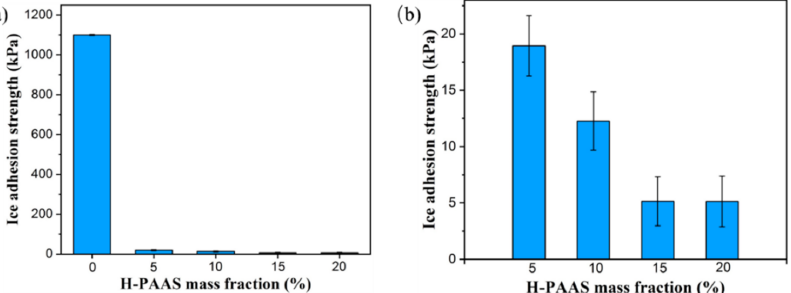
Figure 18. The ice adhesion strength of the surfaces of PP and PP-H-PAAS; ( a ) represented the ice adhesion of specimen 0 to 4, ( b ) represented the ice adhesion of specimen 1 to